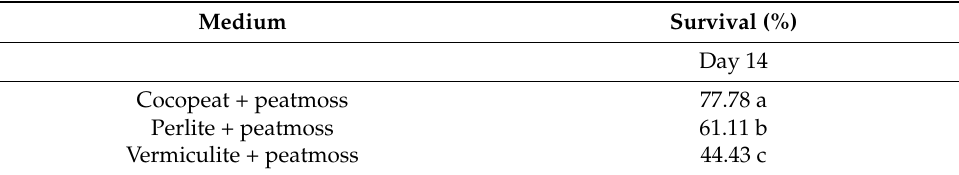
Table 5. Effect of potting medium on acclimatization of C. caesia plantlets . Medium Survival (%) Day 14 Cocopeat + peatmoss 77.78 a Perlite + peatmoss 61.11 b Vermiculite + peatmoss 44.43